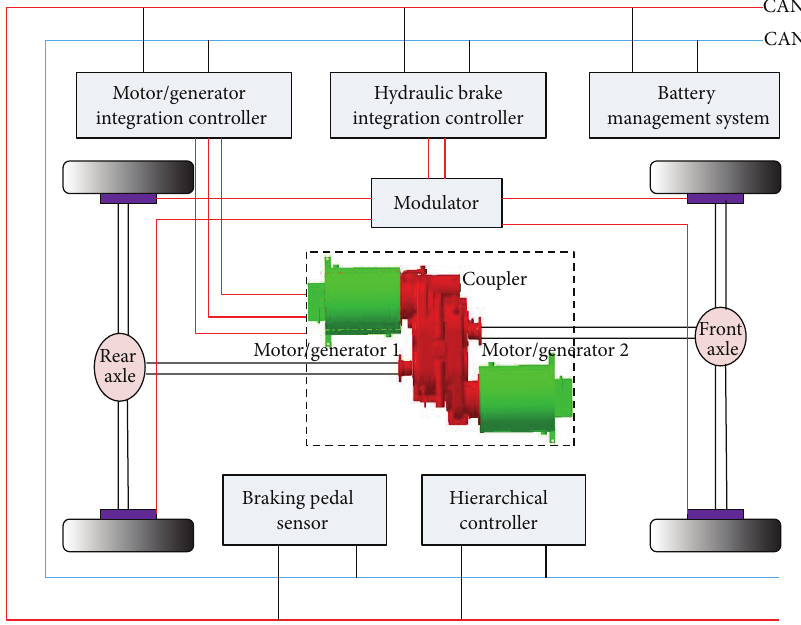
Figure 1: The cooperative braking system